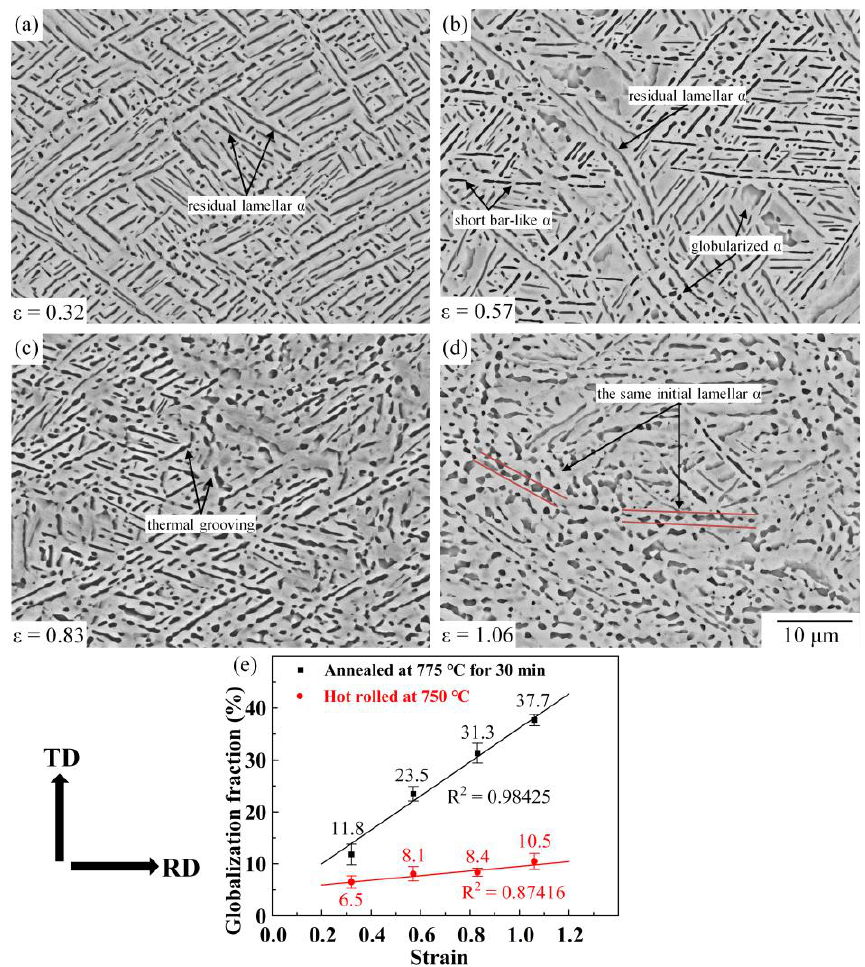
Figure 6. Microstructure of Ti-55511 alloy deformed to different strains and annealed at 775 °C for 30 min: ( a ) 0.32, ( b ) 0.57, ( c ) 0.83, ( d ) 1.06; and ( e ) the globularization fraction of α phase .